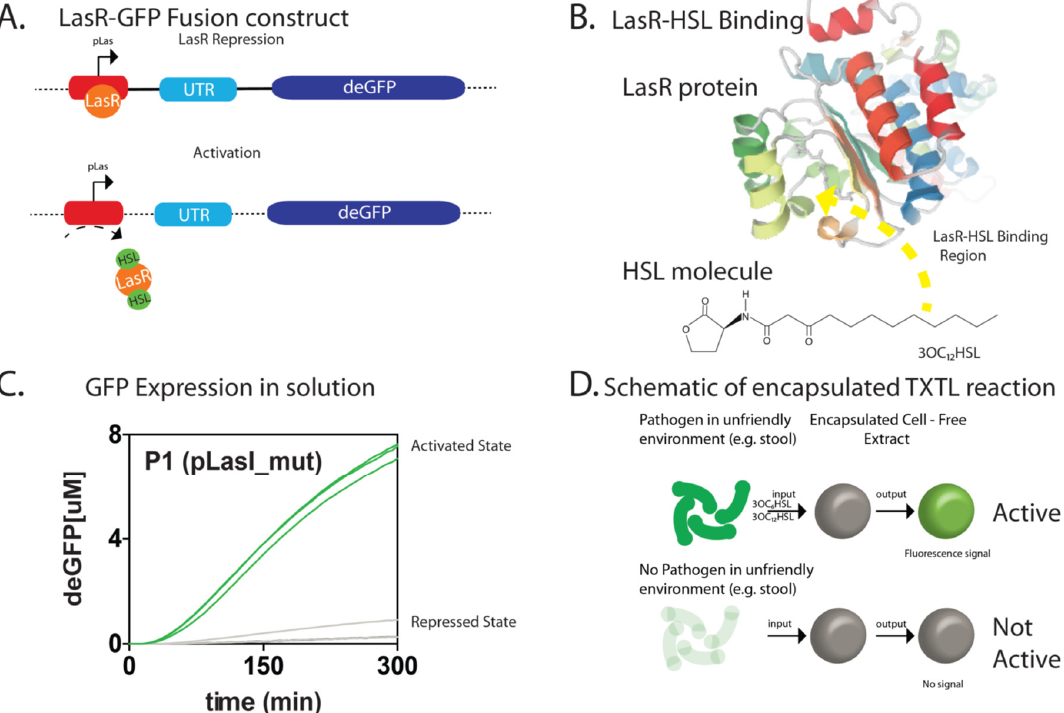
Figure 1. Properties of the LasR-based cell-free method in bulk and in agarose bead forms ( A ). A schematic of the interactions between homoserine lactones and LasR proteins in relation to LasR regulation of transcription ( B ). A green fluorescence protein (GFP) reporter system demonstrates the bulk regulation by LasR in transcriptional regulation ( C ). A crystal structure of the LasR-HSL bounded interaction (courtesy of PDB: 4Y90). ( D ) A schematic demonstrating the use of the LasR-based mechanism in agarose transcription and translation (TXTL) beads.